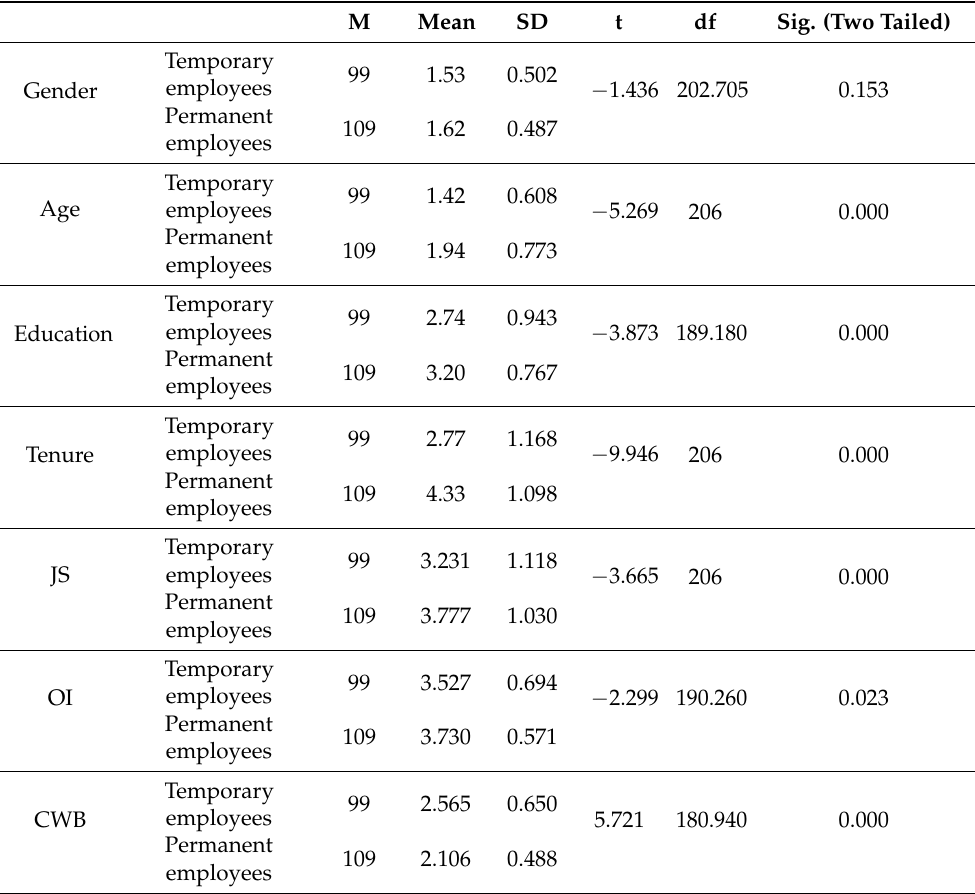
Table 1. Independent-samples t -test for employees’ demographic information.